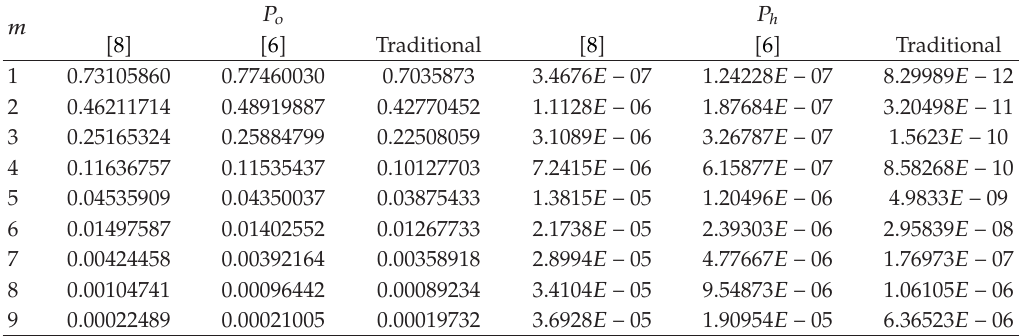
Table 2: Comparison of di ff erent algorithms for the case N (cid:8) 10, λ o (cid:8) 5, λ h (cid:8) 1, μ o (cid:8) 5, μ h (cid:8) 1 .